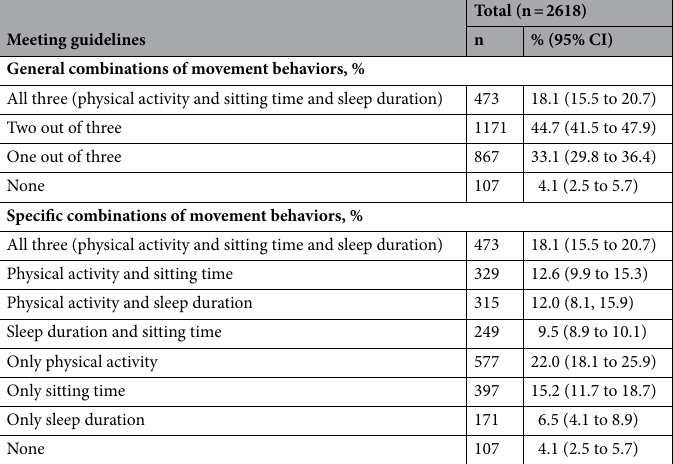
Table 2. Proportion [% (95% CI)] of participants meeting the physical activity, sitting time and sleep duration and combinations of these guidelines. Meeting guidelines was defined as ≥ 600 MET-min/week −1 of physical activity, ≤ 8 h/day of sitting time, and between 7 and 9 h/day of sleep